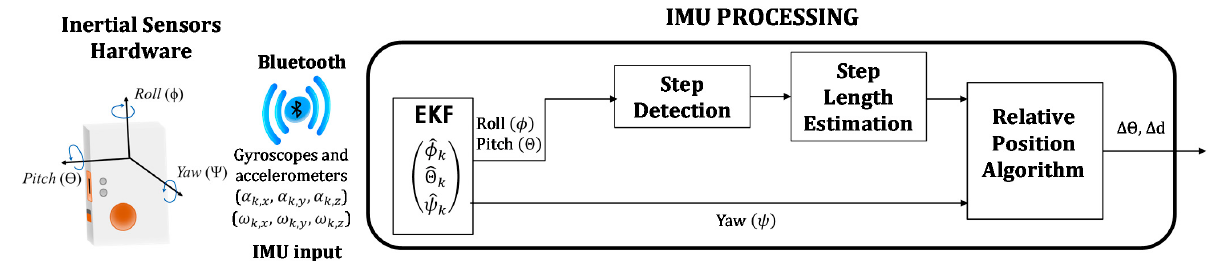
Figure 10. Block diagram of the inertial measurement unit (IMU) processing tasks.